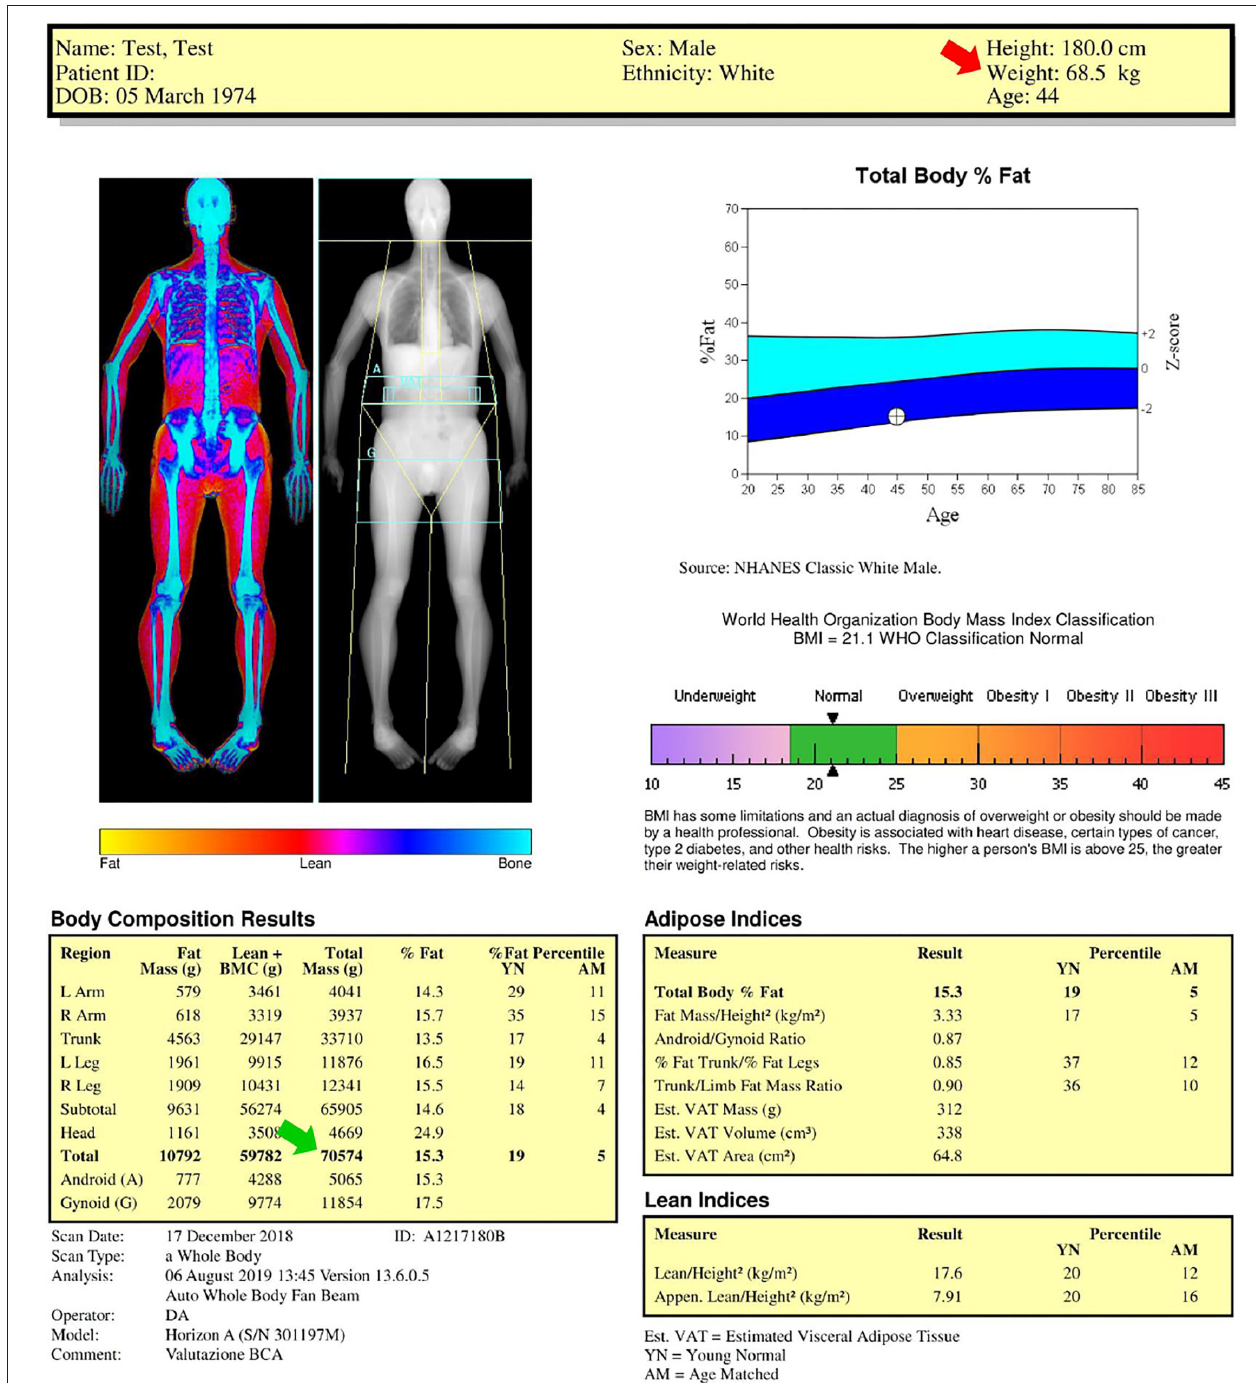
FIGURE 1 | Dual-energy X-ray absorptiometry (DXA) report of body composition for one representative healthy male subject. Color image map shows the relative distribution of fat (yellow), lean tissue (orange and red), and bone (blue), while the crystal image map shows the (yellow) cut lines used to distinguish the standard regions of interest considered for body composition assessment (upper limbs, lower limbs, and trunk) and highlights the gynoid (G)/android (A) areas and the visceral adipose tissue (VAT) slice (light blue regions). Body composition results, body mass index chart, total body fat percentage chart, adipose indices, and lean indices are also reported. AM, age-matched percentile value; BMI, body mass index; BMC, bone mineral content; YN, young normal percentile value.